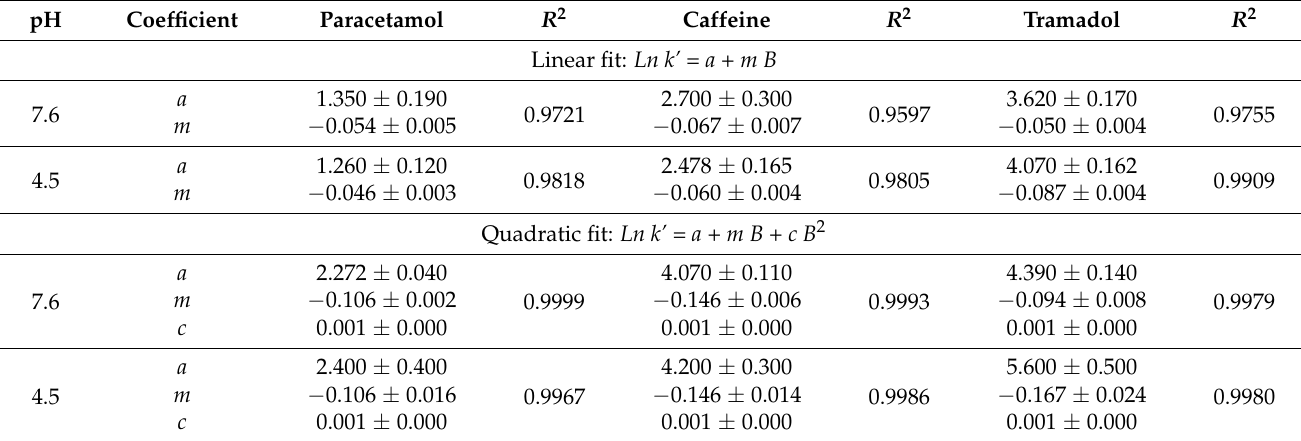
Table 1. Parameter values and standard deviation ( ± SD) obtained for linear and quadratic fits of Ln k’ vs. % MeOH at two pH situations. ( R 2 is the coefficient of